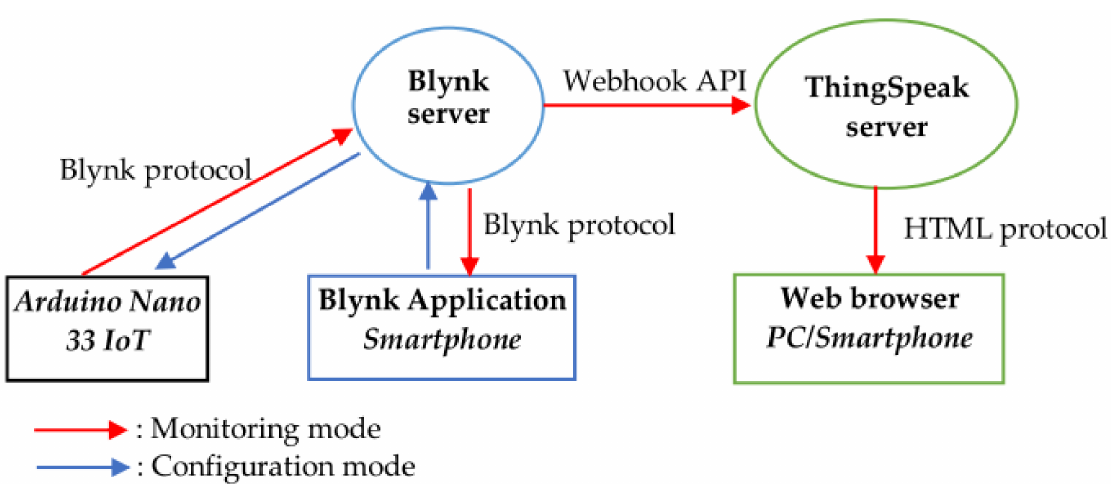
Figure 4. Data communication between embedded device, Blynk, and